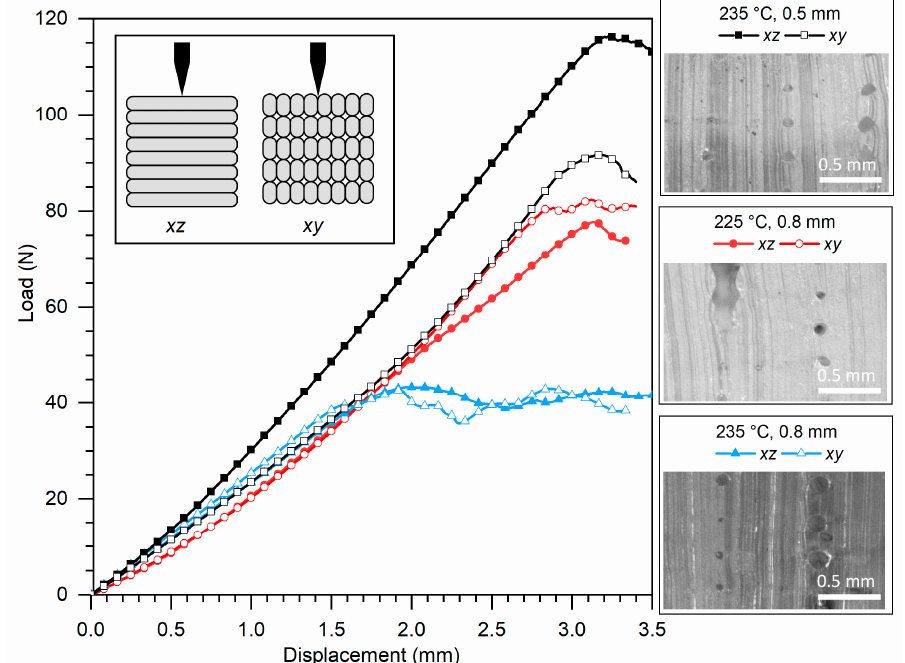
Figure 11. Compression cut test results for 3D printed Ninjaflex under three print conditions: 225 ◦ C with a 0.8 mm infill distance, 235 ◦ C with a 0.8 mm infill distance and 235 ◦ C with a 0.5 mm infill distance. The graph is accompanied by microscopy images of the cross-section in the xz -plane. Scale bars represent 0.5mm.